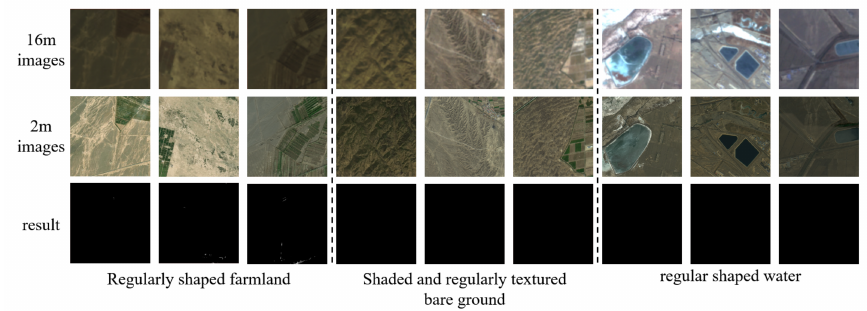
Figure 11. Scene classes that are easily confused during scene classification.